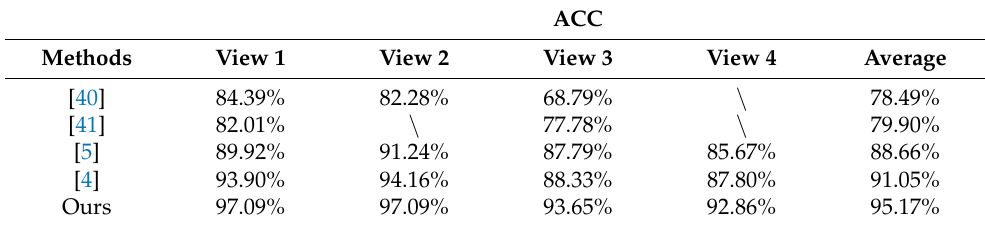
Table 3. Comparisons with the SOTAs.